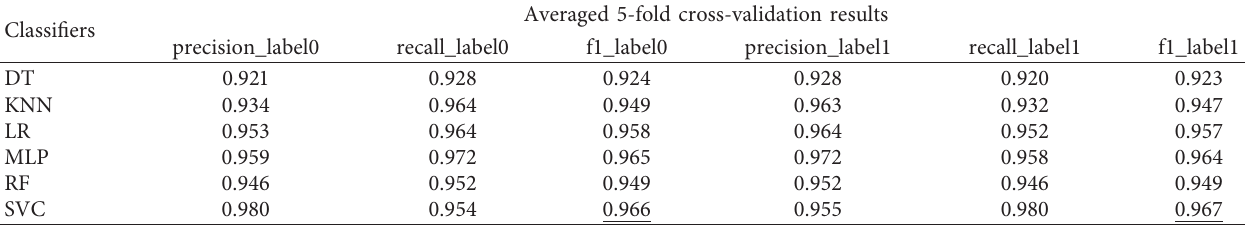
Table 3: Averaged 5-fold cross-validation results of each classifier with original features.